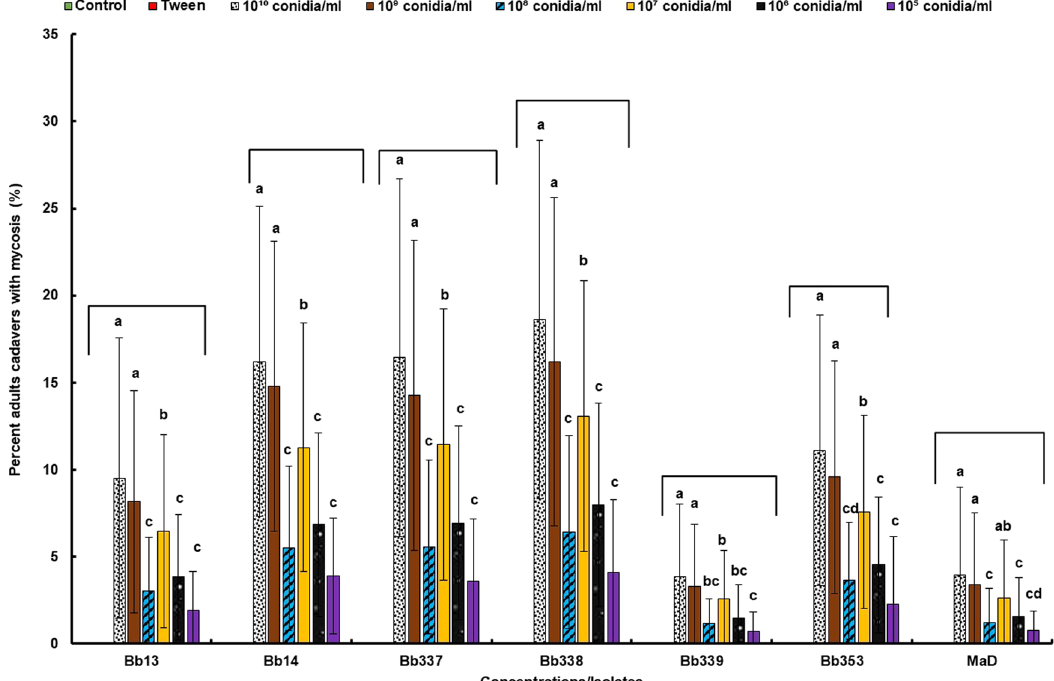
Fig. 6 Cadavers of Zeugodacus cucurbitae adults emerged from enclosed pupae with fungal growth after treatment different concentrations of isolates of Beauveria bassiana and Metarhizium anisopliae in larval inoculation